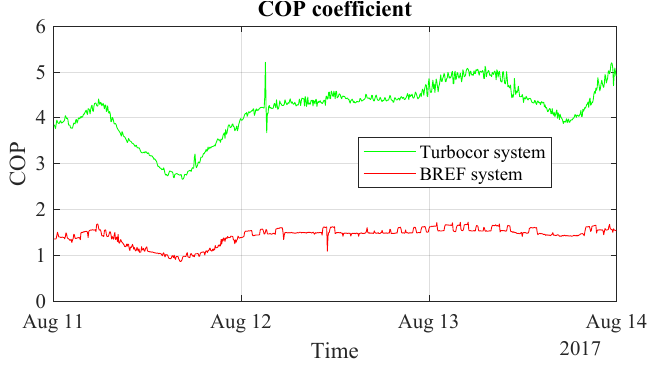
Figure 17. COP on 11–13 August 2017. Table 6. COP profile parameters on 11–13 August